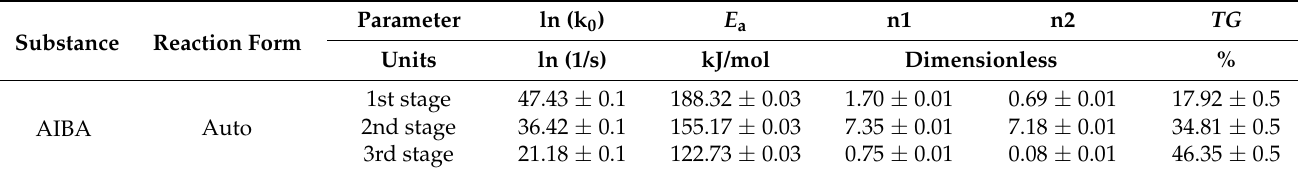
Table 2. Thermokinetic parameters evaluation results of the AIBA.